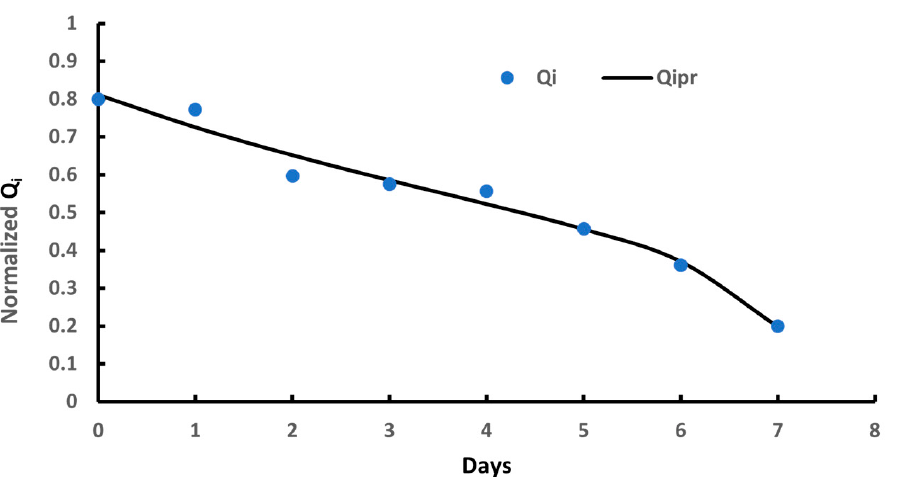
Figure 1. Experimental and predicted normalized quality index (Q i ) of the laban drink during stor- age.